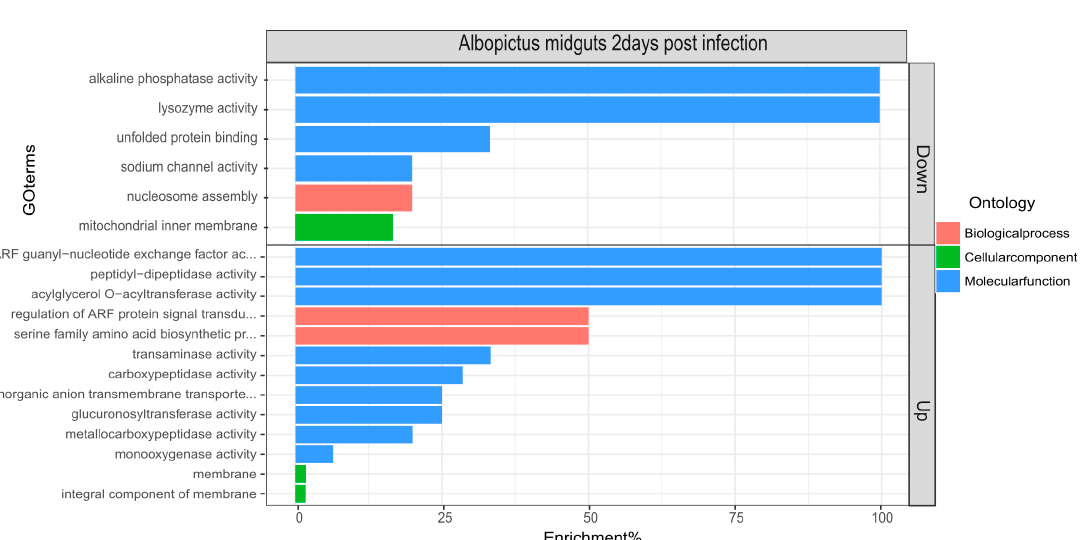
Table 2. List of genes validated by qRT-PCR and comparison of expression fold changes. Genes ARF GTPase-activating protein GIT2 − 8.7 NPC2 homolog Translocon-associated protein subunit delta